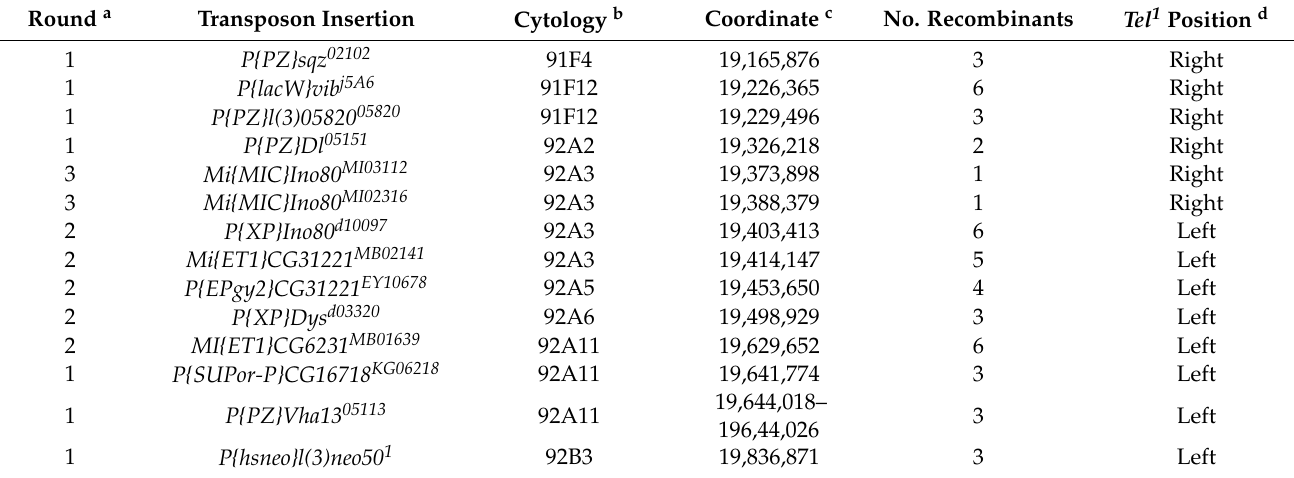
Table 1. Recombinants obtained from each transposon used for site-specific